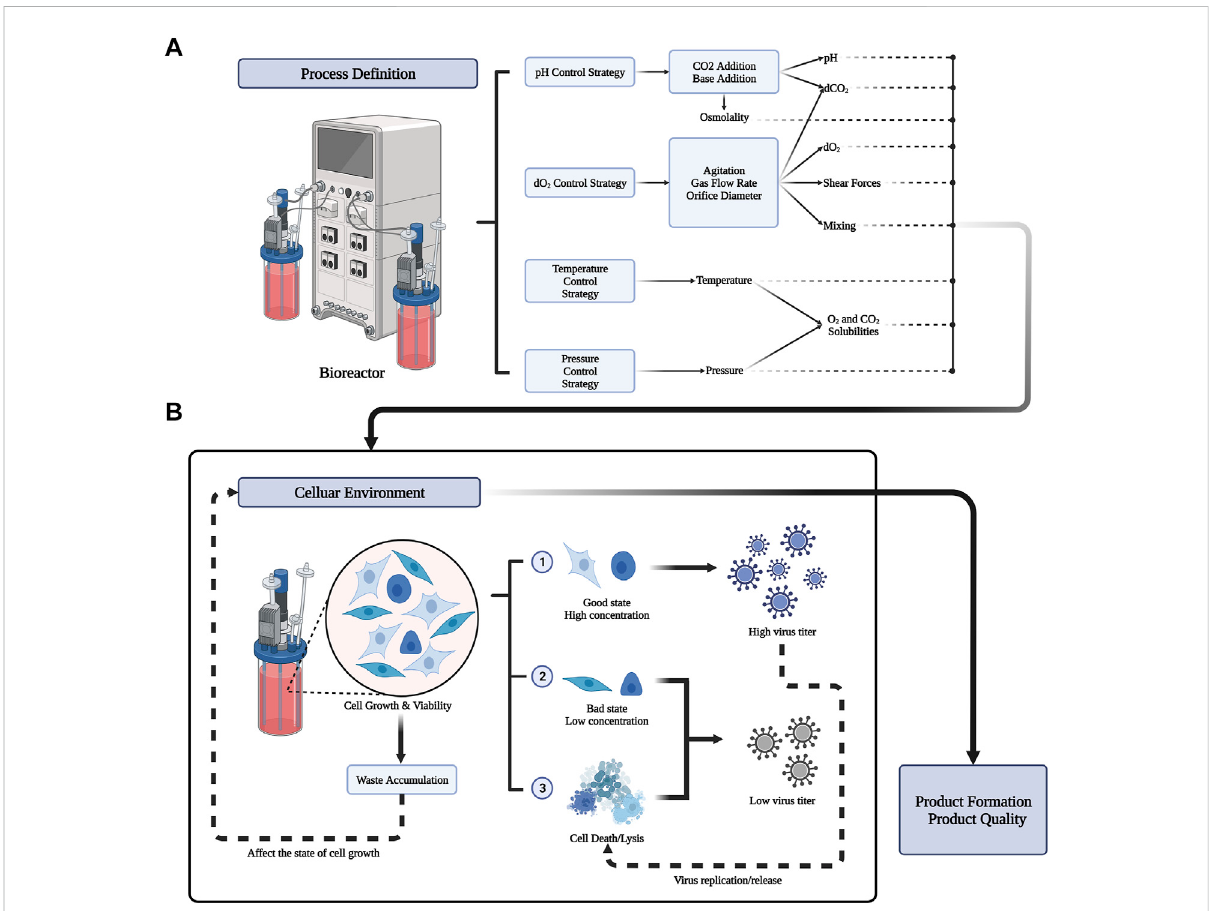
FIGURE 2 Process de fi nition in bioreactor and its result in fl uence in celluar environment. (A) Bioreactors can preset important parameter values through four strategies (pH Control Srategy, dO2 Control Strategy, Temperature Control strategy, pressure control strategy). The output of the process includes physical and chemical parameters such as pH, solubility of different gases, temperature, osmotic pressure, shear force and so on. Different process de fi nitions have a great in fl uence on the cellular environment. (B) Different celluar environment will lead to different growth states of cells. Good cell state and higher cell concentration can produce more virus titers. But the replication and release of the virus can also lead to cell death. Meanwhile, the accumulation of waste from cell metabolism will affect the celluar environment. The state of the cellular environment ultimately determines the formation and quality of the